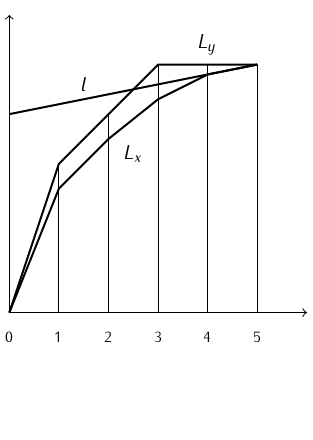
Fig 2. L x , L y and the linear function l , n = 5